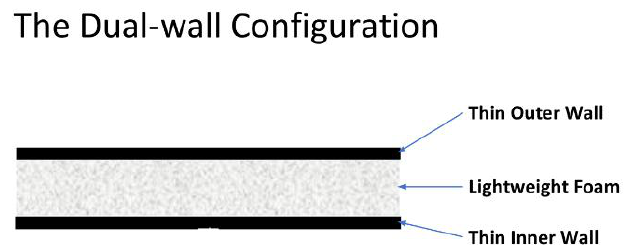
Figure 1. Sketch of a Dual-Wall Configuration Stuffed with Light-weight Foam.